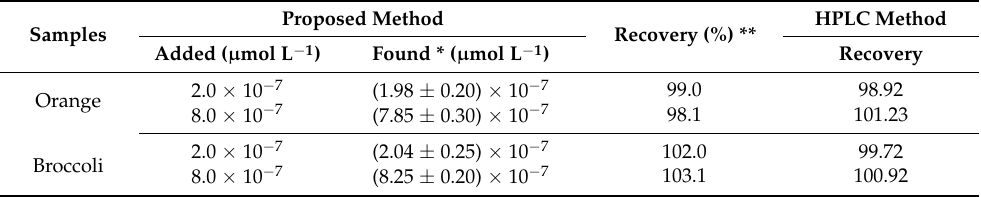
Table 3. Results obtained from the application of the proposed sensor for the detection of folate at low concentrations in other food samples (orange and broccoli).